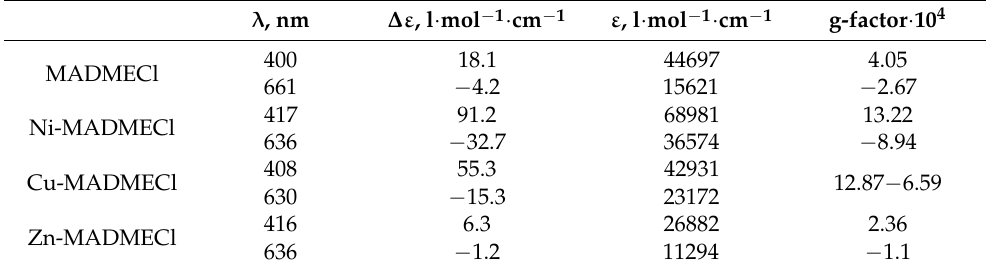
Table 5. Spectral parameters of macroheterocycles in chloroform.